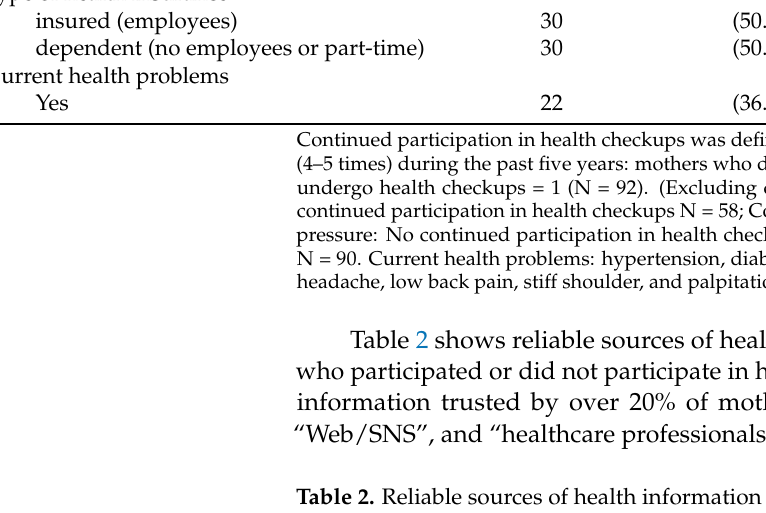
Table 2. Reliable sources of health information for mothers’ behavior by those who participated or did not participate in health checkups (N =